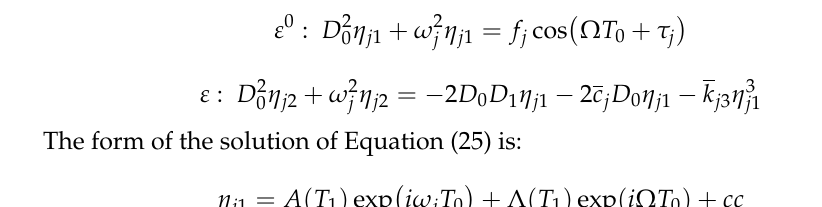
( ) ( ) σ = , 5,15 c . Figure 8. Excitation amplitude response curves of the first mode with ( c 1 , σ ) = ( 5,15 ) . 1